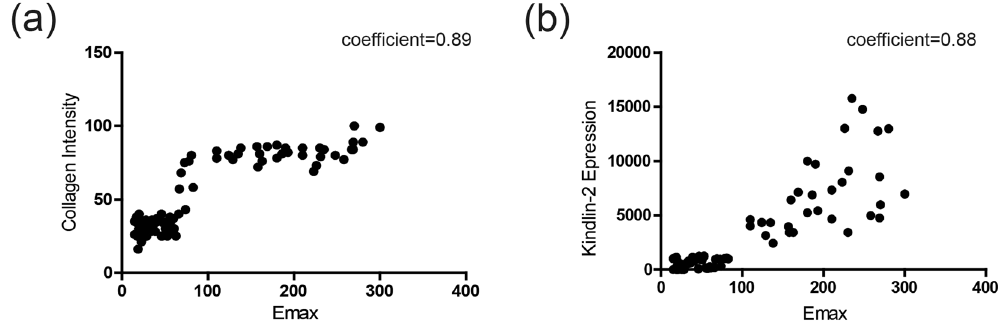
Figure 3. Correlation of Emax and collagen/Kindlin-2 expression in breast nodules. ( a ) Collagen intensity correlated positively with Emax (Coefficients = 0.89). ( b ) Kindlin-2 expression correlated positively with Emax (Coefficients = 0.88). Correlations were evaluated with Pearson’s test, and correlation coefficients were calculated. Coefficients ≥ 0.7 indicate a strong correlation; values ≥ 0.4 but < 0.7 indicate a moderate correlation; and values < 0.4 indicate a weak correlation. Emax, maximum elasticity.